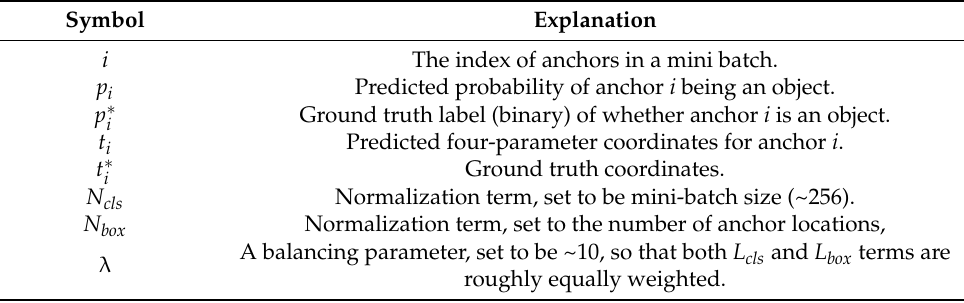
Table 1. Definitions of the symbols used in the loss